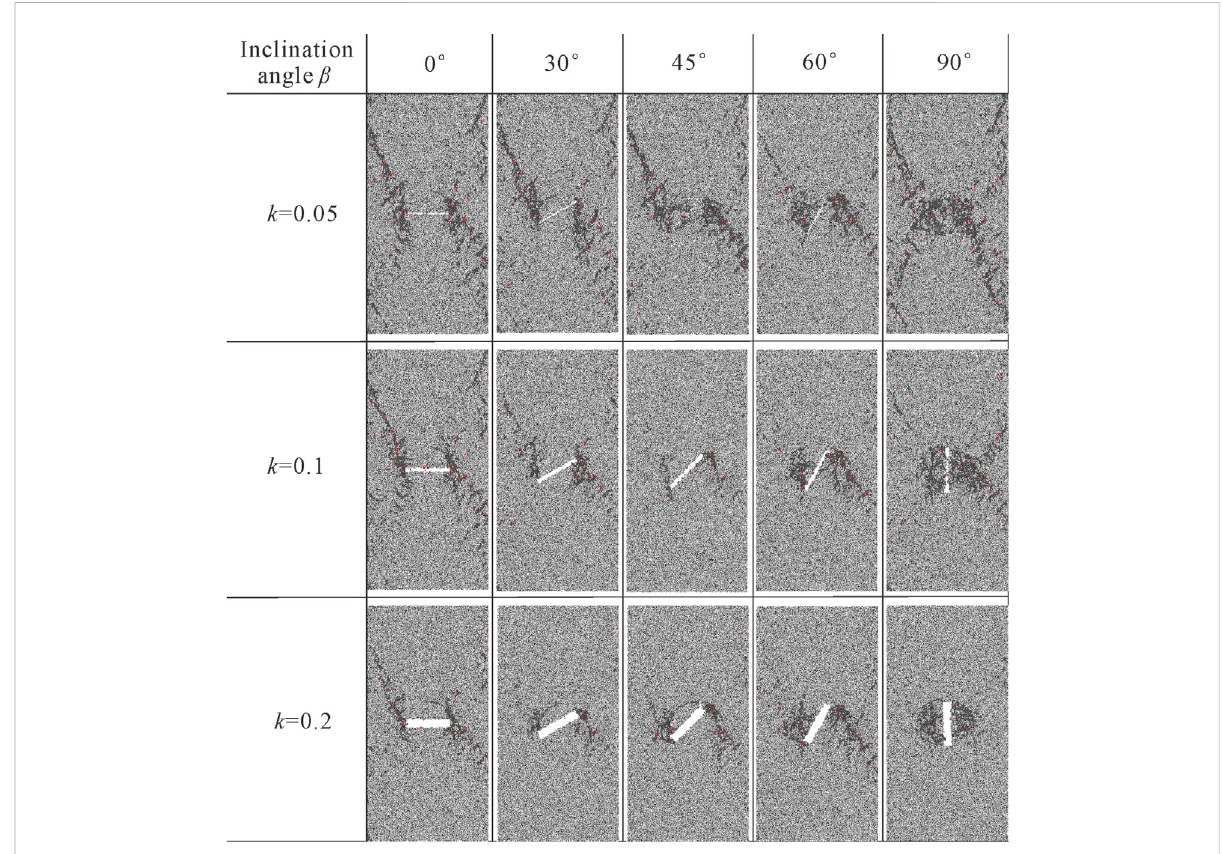
FIGURE 9 The ultimate failure modes of numerical samples with different width-to-length ratios and inclination angles.